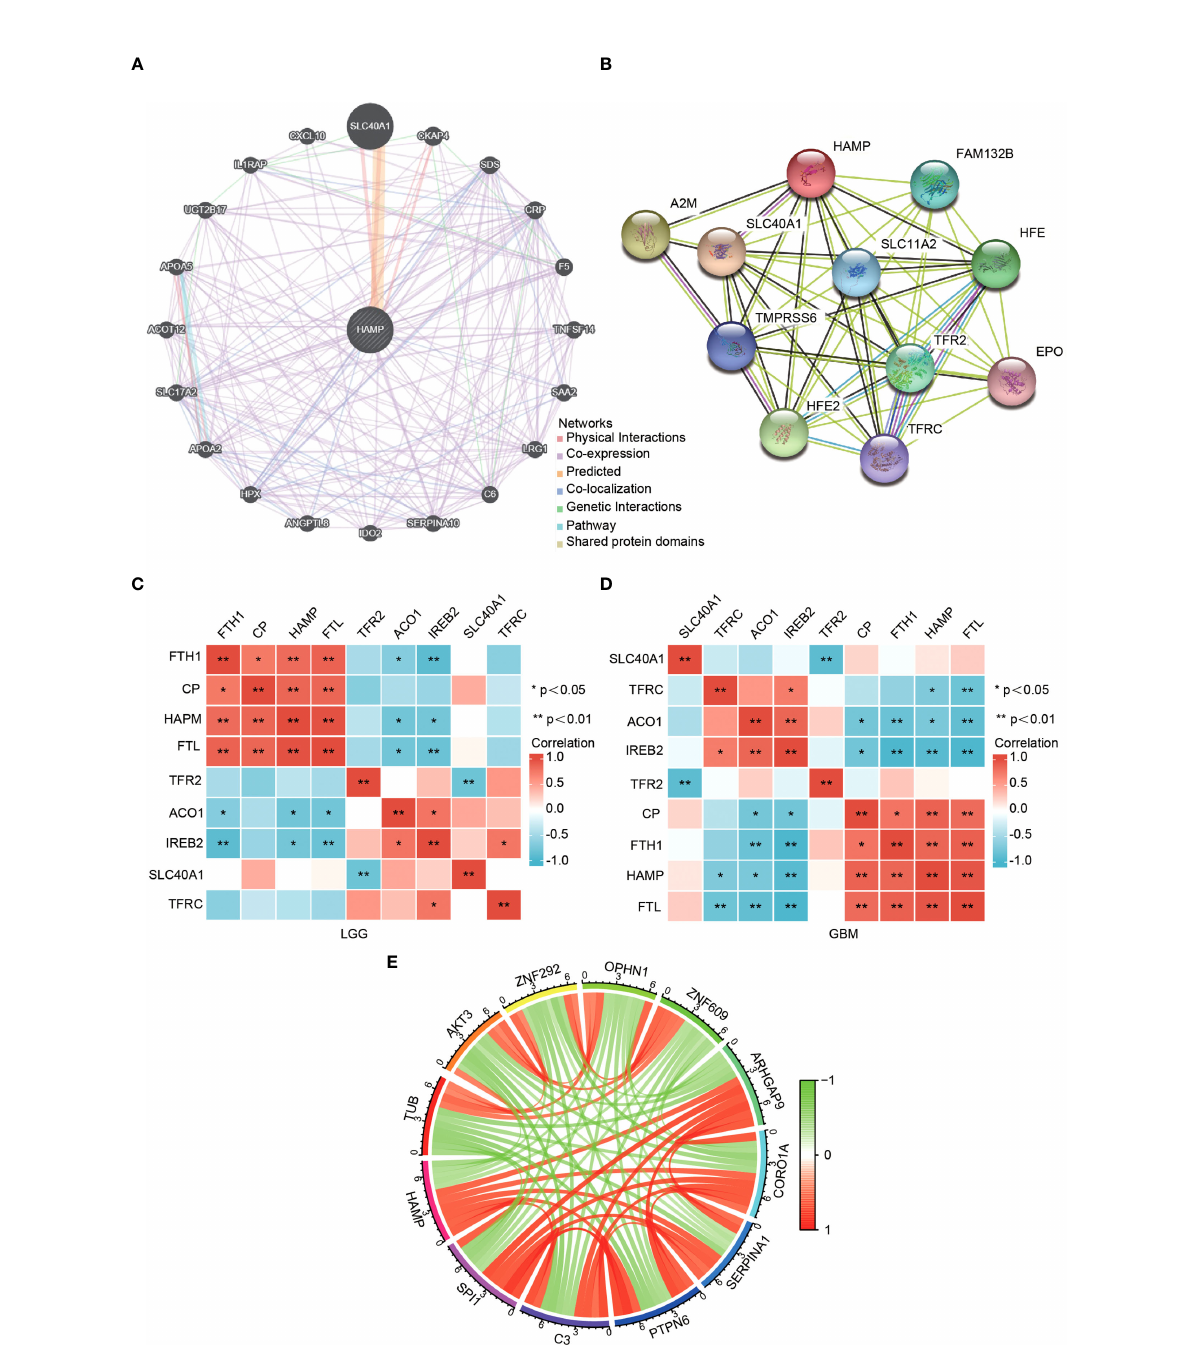
FIGURE 5 Analysis of hepcidin-interacting genes and proteins. (A) The gene – gene interaction network of hepcidin was constructed using GeneMANIA. (B) The PPI network of hepcidin was generated using STRING. (C, D) A heatmap shows the correlations between hepcidin and iron metabolism- related genes in LGG (C) and GBM (D) . (E) The gene circle map of hepcidin from the co-expression analysis. Red lines represent positive correlations with hepcidin, and green lines represent negative correlations with hepcidin. *p < 0.05 and **p <